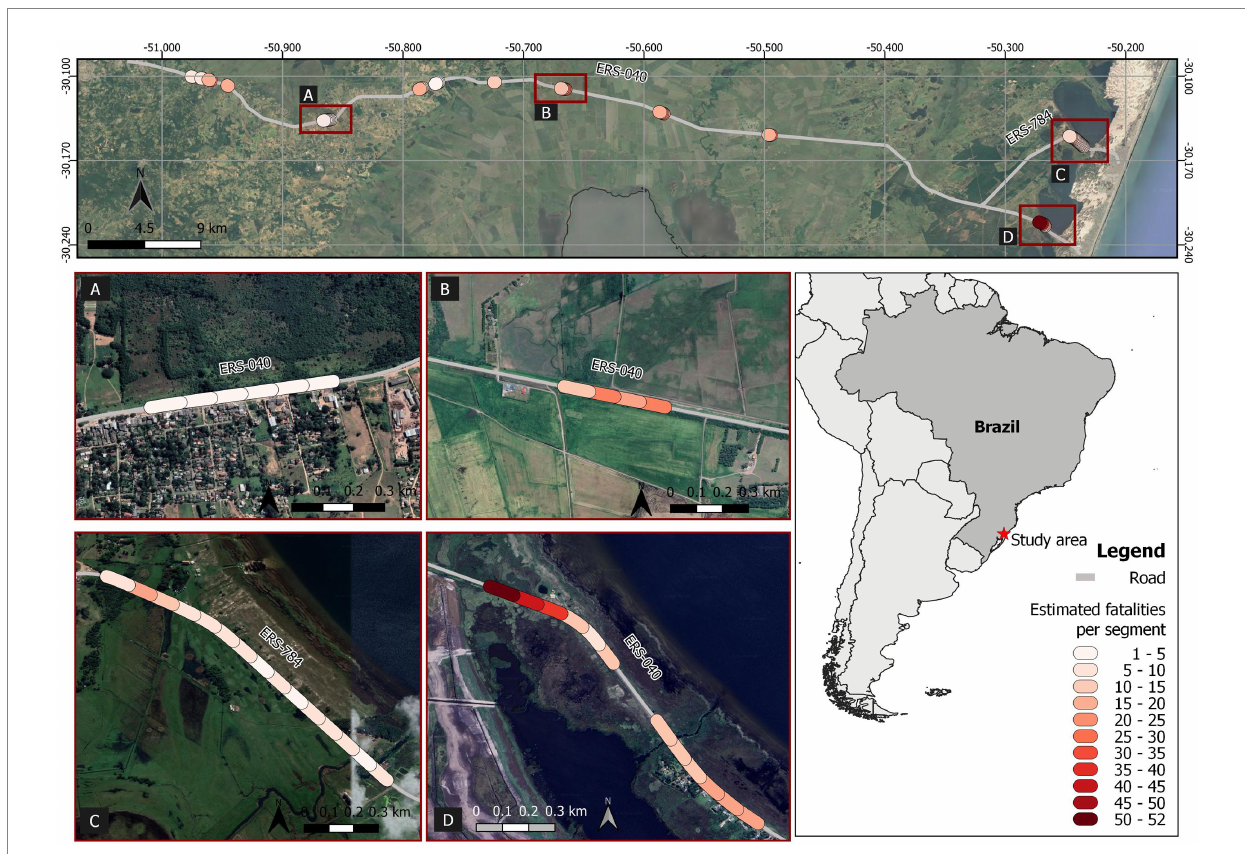
FIGURE 2 Road segments (100 m length) sampled for amphibian fatality estimation in southernmost Brazil (ERS-040 and ERS-784 roads) aiming at identifying priority locals for mitigation. In the upper image, colored circles represent estimated fatalities for the sampled segments, from which some of them (framed by squares) are shown in detail from (A–D) . Map data © OpenStreetMap contributors,